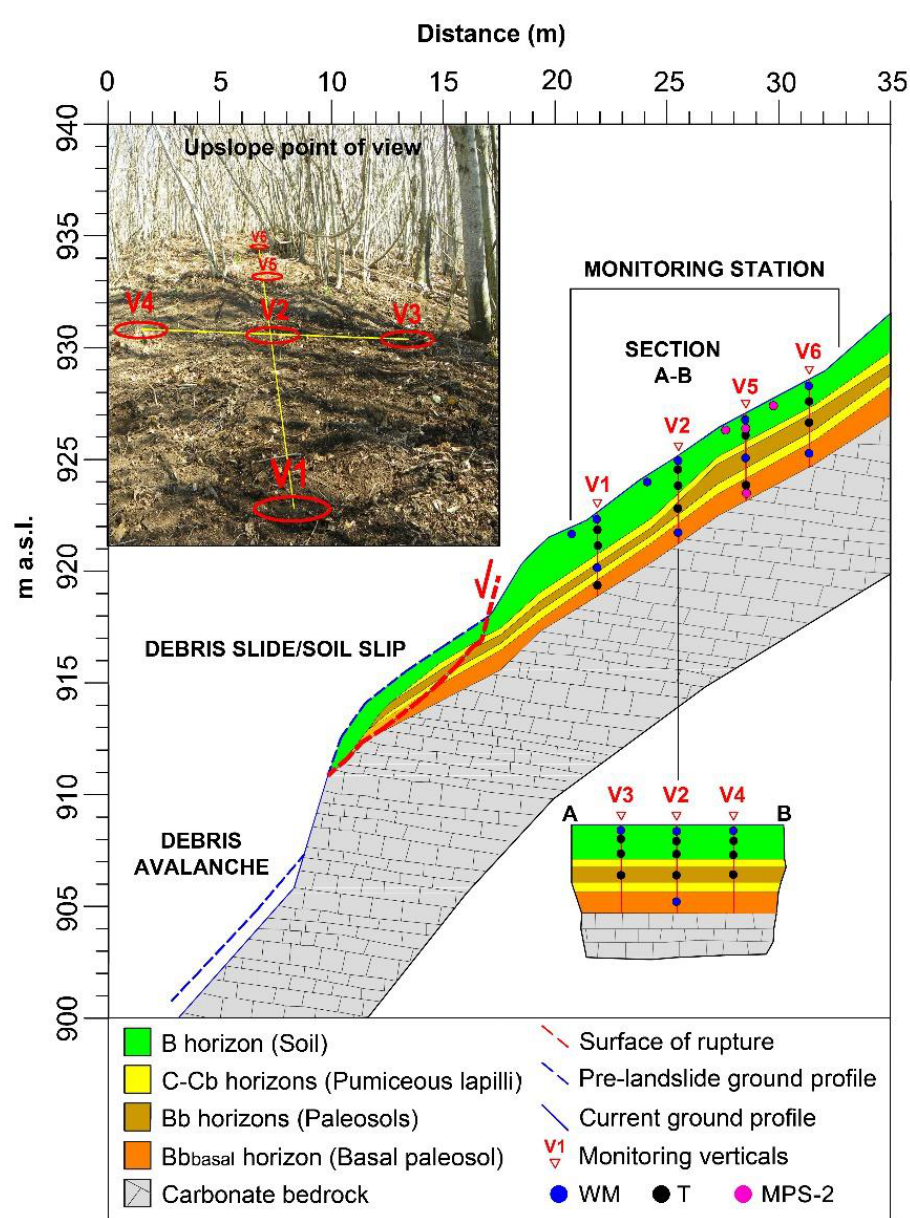
Figure 3. Graphical plan of monitoring verticals (V1–V6) and location of the tensiometers (T), Watermark (WM) and MPS-2 sensors in the test-site geological model. The upper-left box shows an upslope view of one of the monitoring sites, modified from [38]. Table 1. Type and number of sensors installed in the pyroclastic fall soil horizons (except for the C horizon), and range depth.